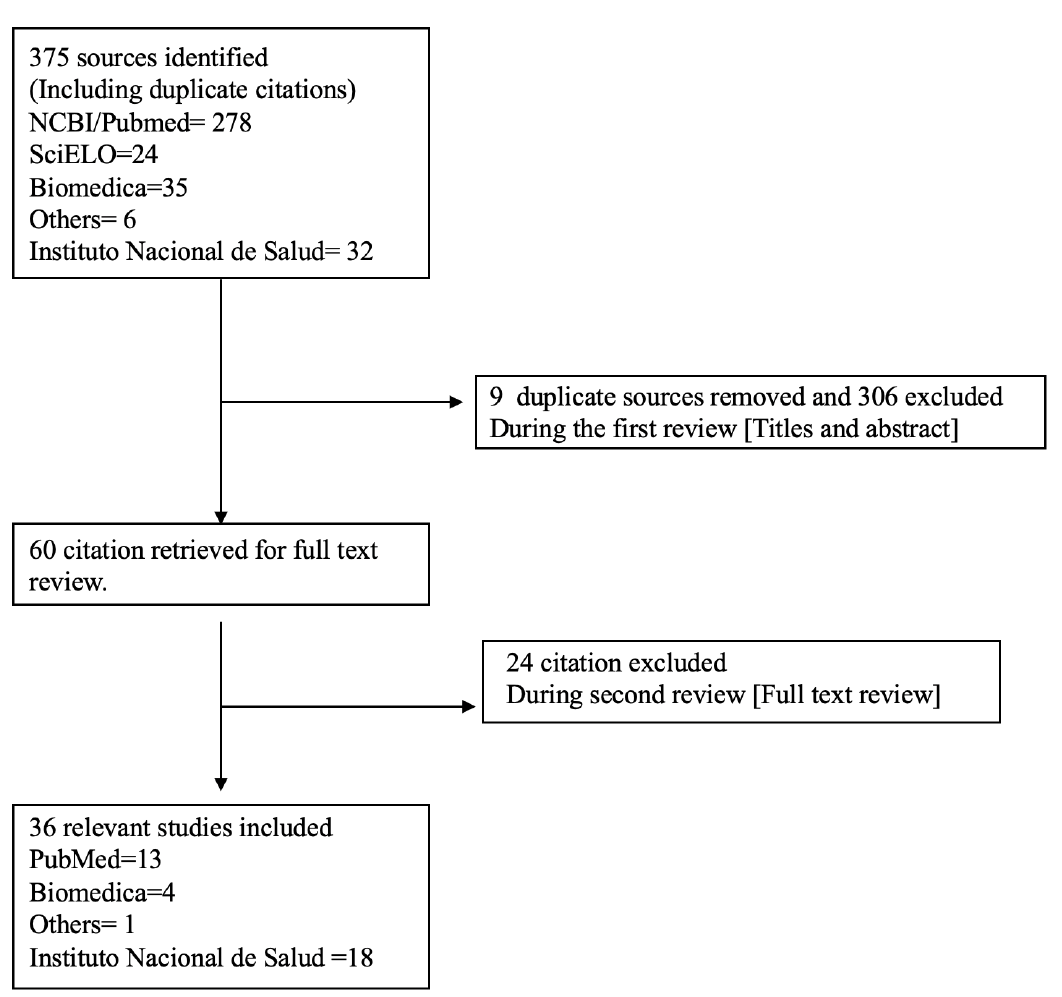
Figure 1. Flowchart of the literature search and included studies.